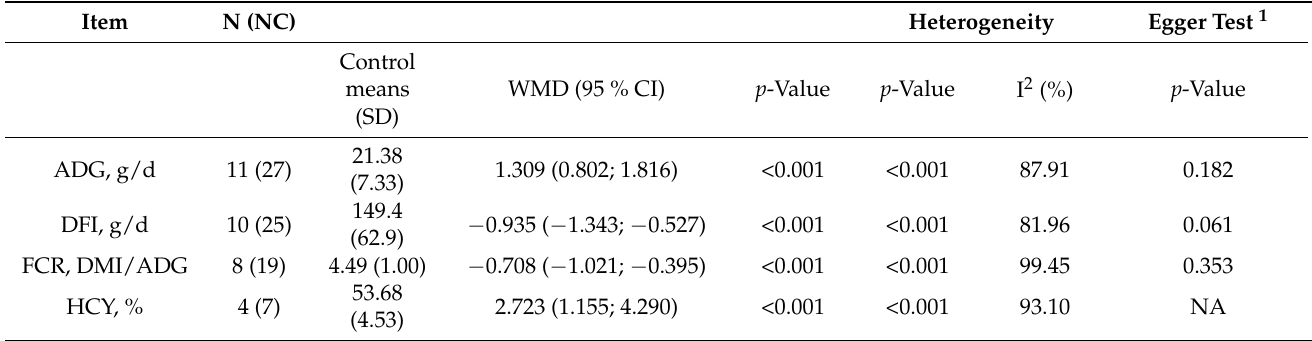
Table 2. Growth performance of rabbits supplemented with bee pollen.